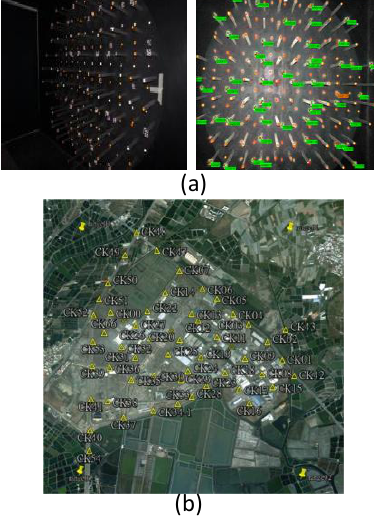
Figure 9. ( a ) Indoor calibration field; ( b ) Distribution of GCPs in test